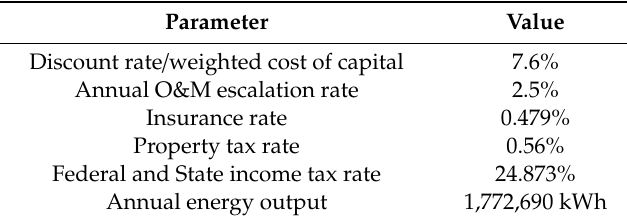
Table 36. Annualization pro forma assumptions and